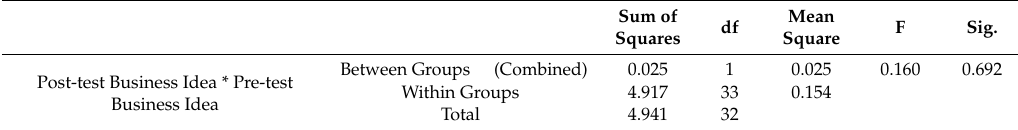
Table 8. Business idea ANOVA Table for entrepreneurial classes.